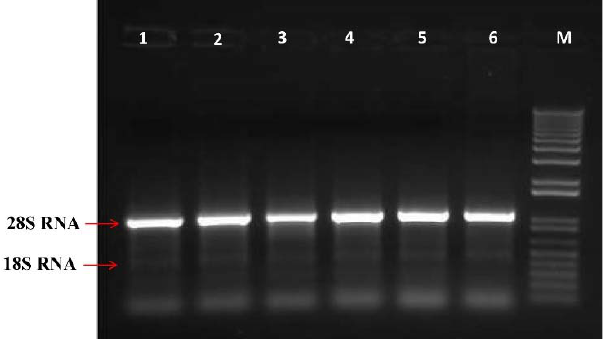
Figure 2. Agarose gel electrophoresis shows total RNA extracted from Persian lime leaves in some treatments (1: 50 μ M melatonin under mild drought-stress; 2: 100 μ M melatonin under mild treatments (1: 50 µ M melatonin under mild drought-stress; 2: 100 µ M melatonin under mild drought- drought-stress; 3: 150 μ M melatonin under mild drought-stress; 4: 50 μ M melatonin under severe stress; 3: 150 µ M melatonin under mild drought-stress; 4: 50 µ M melatonin under severe drought- drought-stress; 5: 100 μ M melatonin under severe drought-stress; 6: 150 μ M melatonin under severe stress; 5: 100 µ M melatonin under severe drought-stress; 6: 150 µ M melatonin under severe drought- drought-stress; M: Marker III). stress; M: Marker